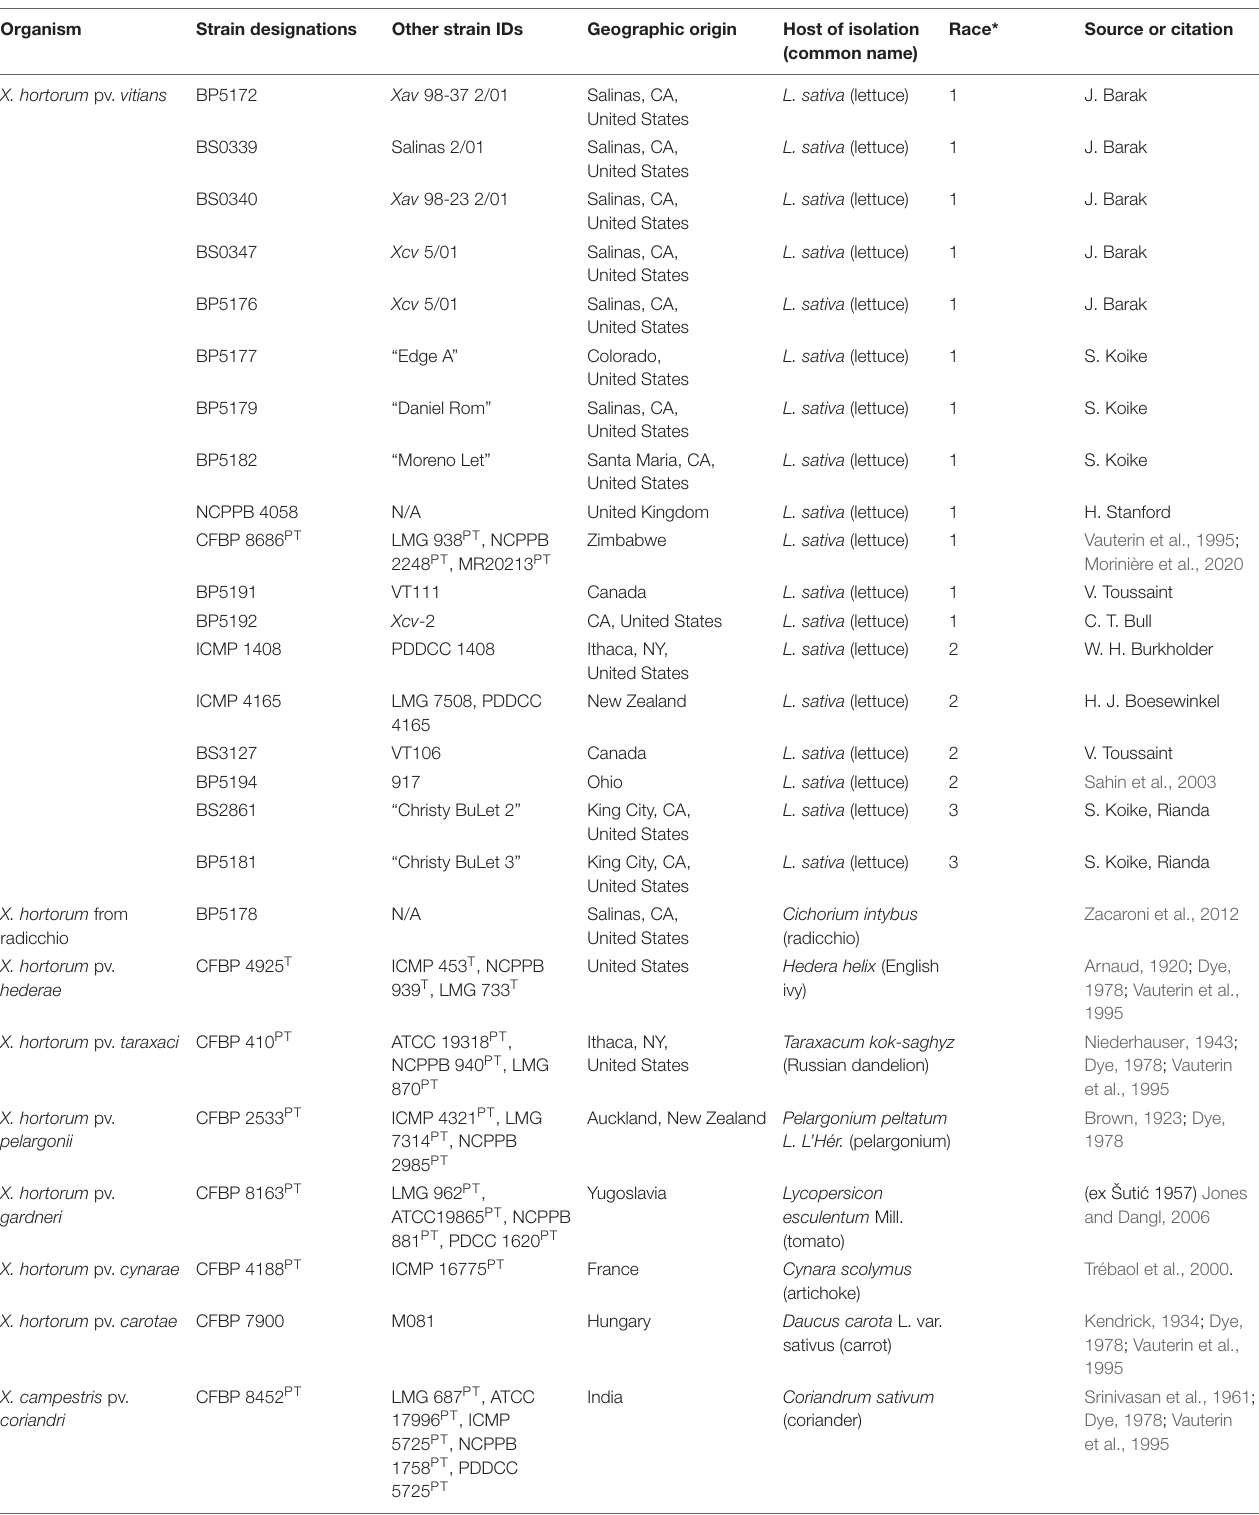
TABLE 1 | Xanthomonas strains included in this study.